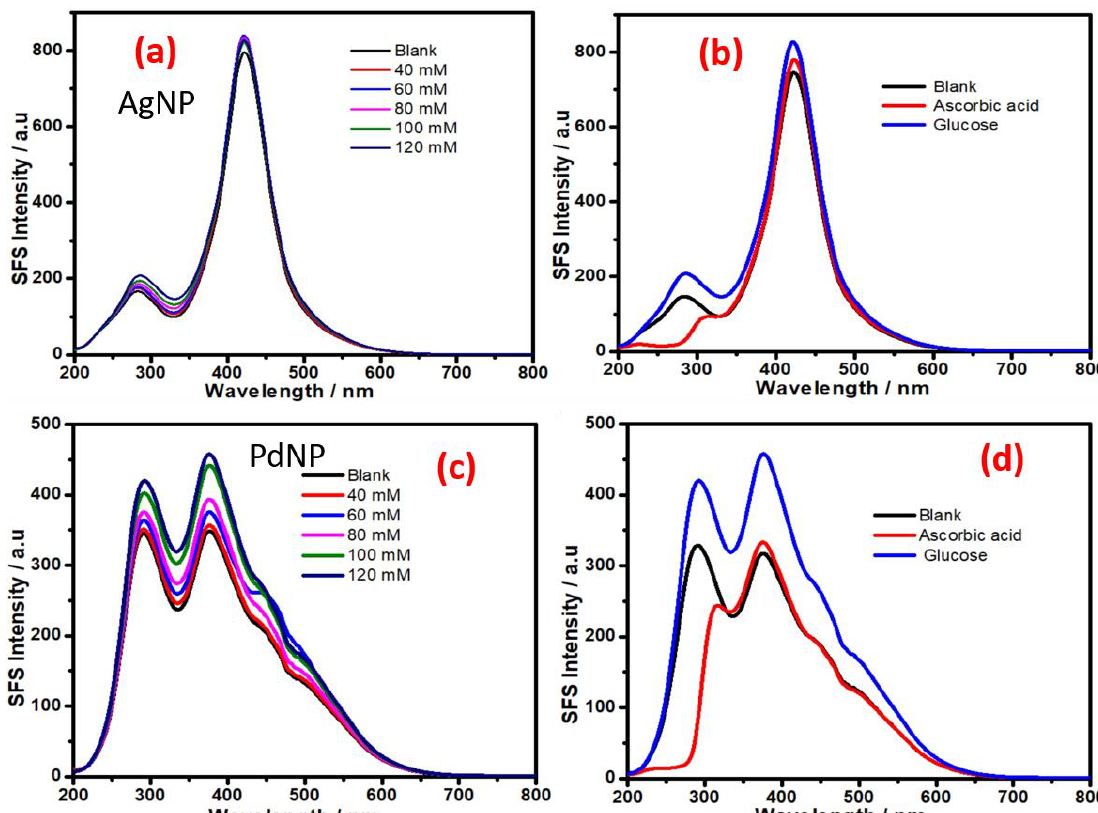
Figure 7. Synchronous fluorescence spectra at delta δλ = 0 nm, recorded at various concentrations of glucose. ( a ) Synchronous fluorescence intensity of AgNPs in the presence of glucose and ascorbic acid. ( b ) Synchronous fluorescence spectra at delta δλ = 0 nm recorded at various concentrations of glucose. ( c ) Synchronous fluorescence intensity of PdNPs in the presence of glucose and ascorbic acid ( d ).